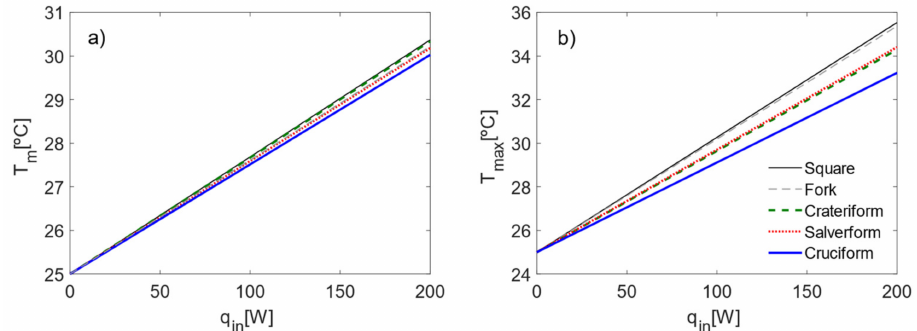
Figure 9. ( a ) Mean and ( b ) maximum temperature of the plate as a function of the thermal power input for all